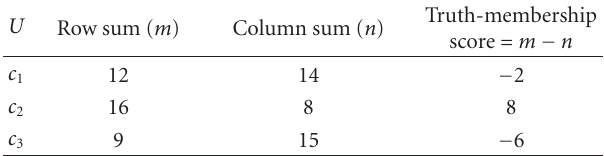
Table 10: False-membership score.